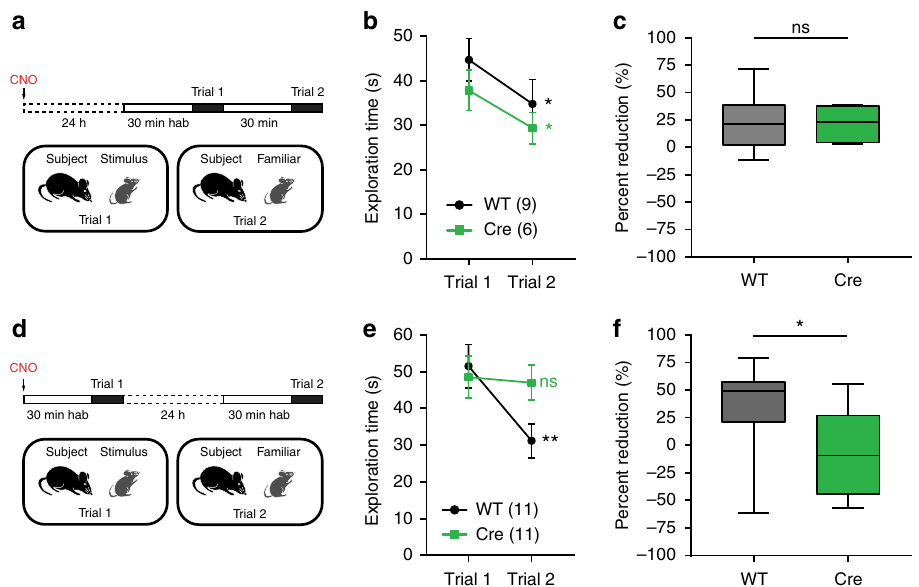
Fig. 2 dCA2 is necessary in the initial stages of social memory formation. a Protocol for experiment examining effect of IP injection of CNO 24 h prior to the direct interaction test. Both WT and Amigo2 -Cre littermates were injected in dCA2 with AAV-DIO-hM4Di-IRES-mCitrine. b WT controls and Amigo2 -Cre mice showed normal decrease in social exploration time during trial 2 (WT: n = 9, t (8) = 2.815, P = 0.0227, paired t test; Cre: n = 6, t (5) = 2.790, P = 0.0384, paired t test). The groups did not differ signi fi cantly (two-way ANOVA: treatment × trial F (1,13) = 0.08127, P = 0.7801). c No difference was found in percent reduction in social exploration time in trial 2 compared to trial 1 between groups (unpaired t test: t (13) = 0.1591, P = 0.8760). d Protocol for a direct interaction test with 24 h intertrial interval. WT and Amigo2 -Cre littermates were injected in dCA2 with AAV-DIO-hM4Di-IRES-mCitrine. Trial 1 was performed 30 min after IP injection of CNO and trial 2 was performed 24 h later. e WT but not Amigo2 -Cre mice displayed decreased social exploration during trial 2 relative to trial 1 (WT: n = 11, P = 0.0040, Sidak ’ s multiple comparisons test; Cre: n = 11, P = 0.9578, Sidak ’ s multiple comparisons test). The groups differed signi fi cantly (two-way ANOVA: treatment × trial F (1,20) = 5.394, P = 0.0309). f Percent reduction in social exploration time was lower in Amigo2 -Cre than WT groups (unpaired t test: t (20) = 2.558, P = 0.0187). Results in b and e show mean ± s.e.m. Box-whiskers plots in c and f present median (center line), extension from the 25th to 75th percentiles (box) and minimal and maximal values (whiskers). * P < 0.05; ** P < 0.01; ns, P >